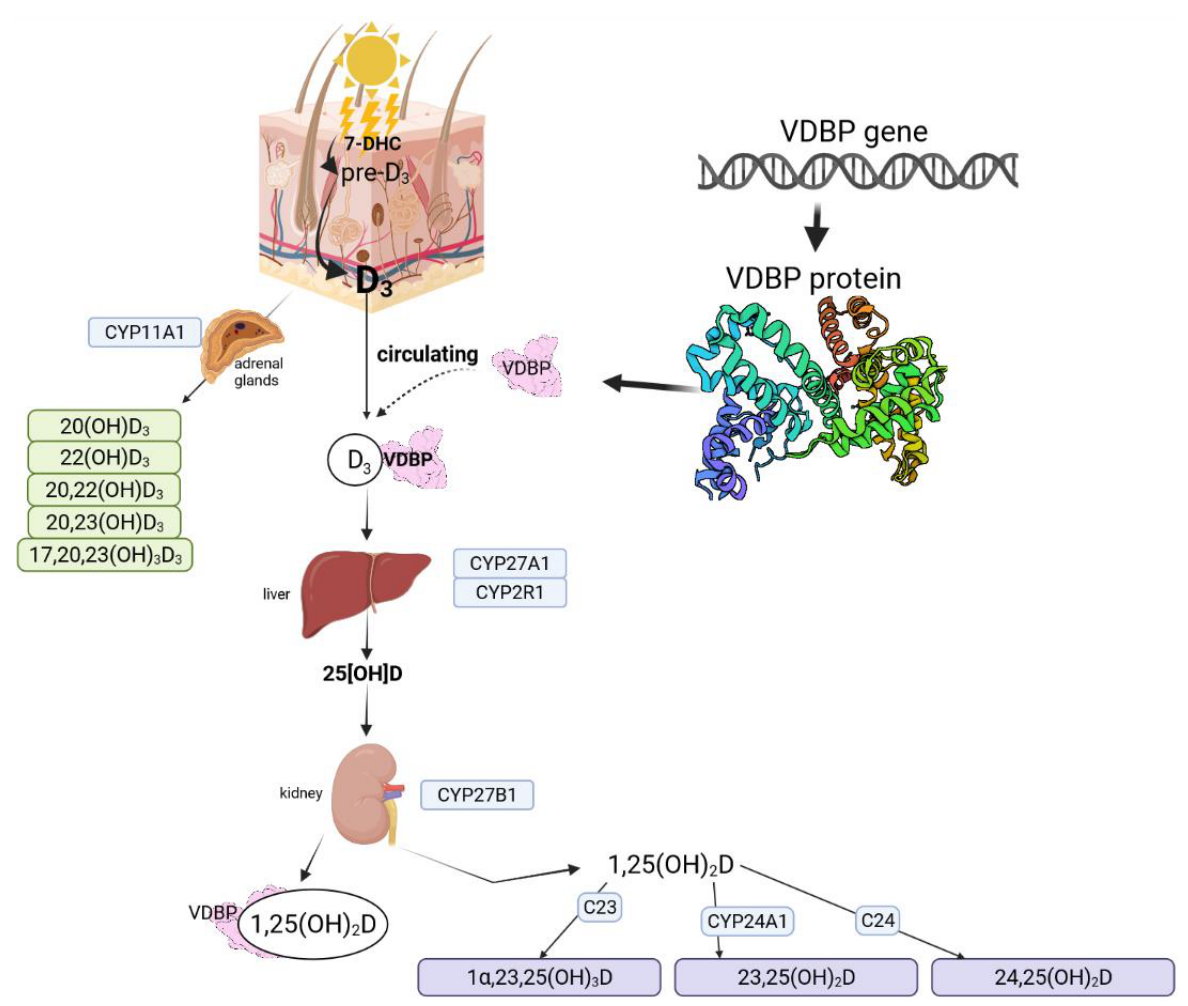
Figure 1. Vitamin D metabolic pathways based on Bikle (2014), Slominski et al. (2012, 2015, 2020), Rozmus et al. (2020) [12,15–18]. Figure fully created with biorender.com (accessed on 1 November 2021).